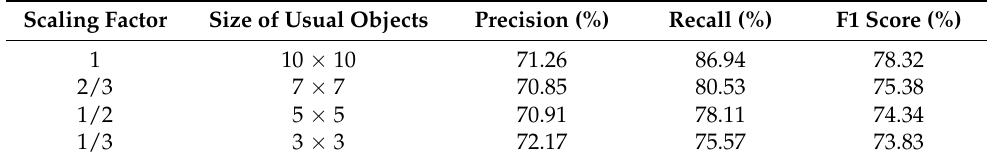
Table 4. Results of different